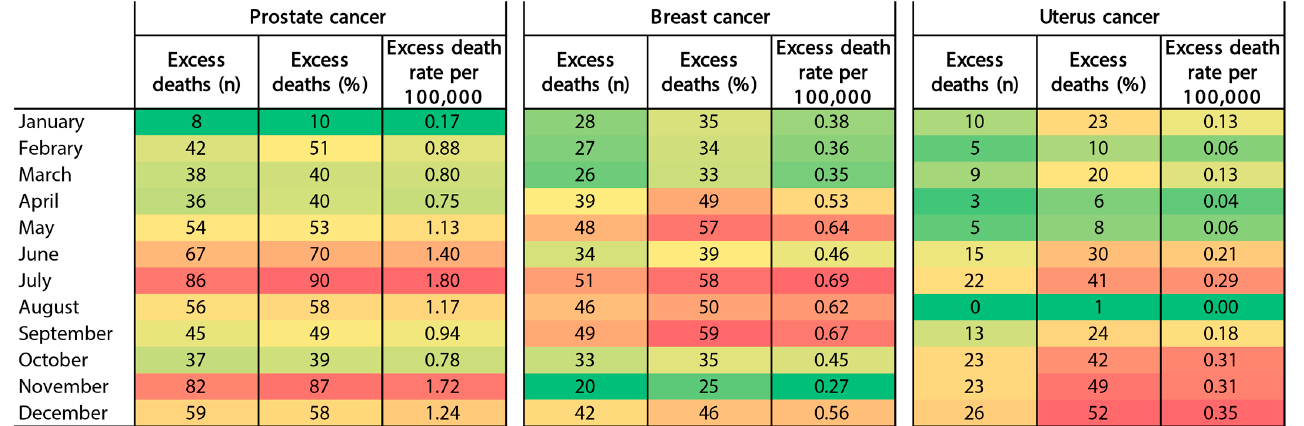
Figure 4. Trends in monthly excess deaths for prostate, breast, and uterus cancer between January and December 2020 in Peru. Color intensity is proportional to rank number (denoted by dark red for “highest excess” to “lowest excess” denoted by dark green).